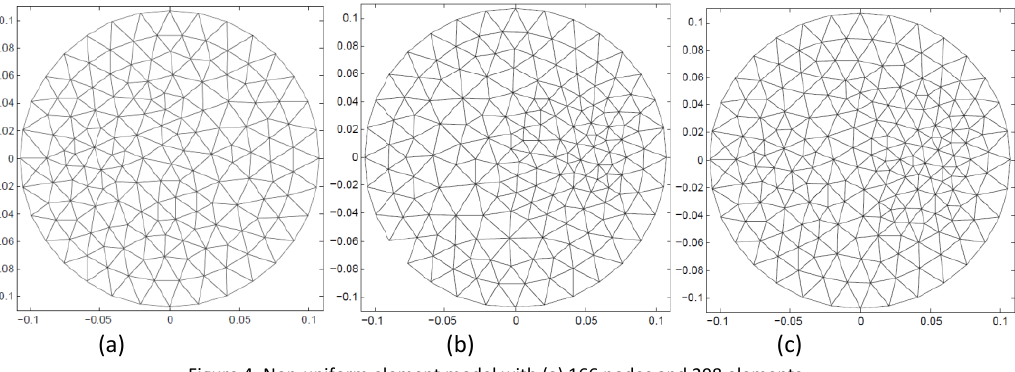
Figure 4: Non-uniform element model with (a) 166 nodes and 298 elements,